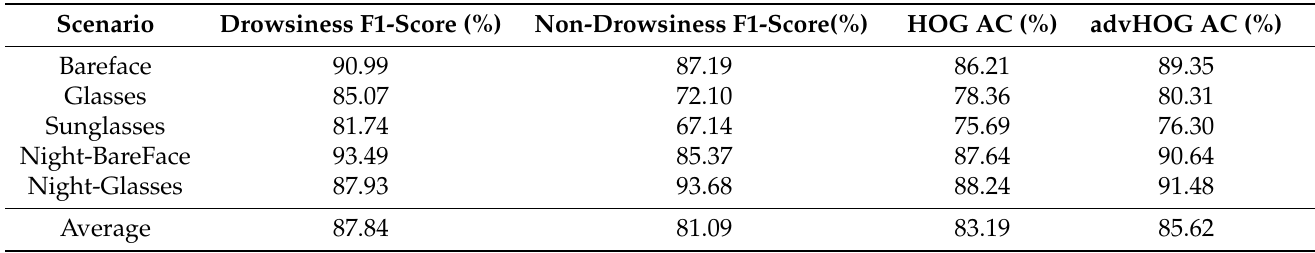
Table 1. Detailed results of the detection performance of the proposed framework on the public NTHU-DDD dataset.